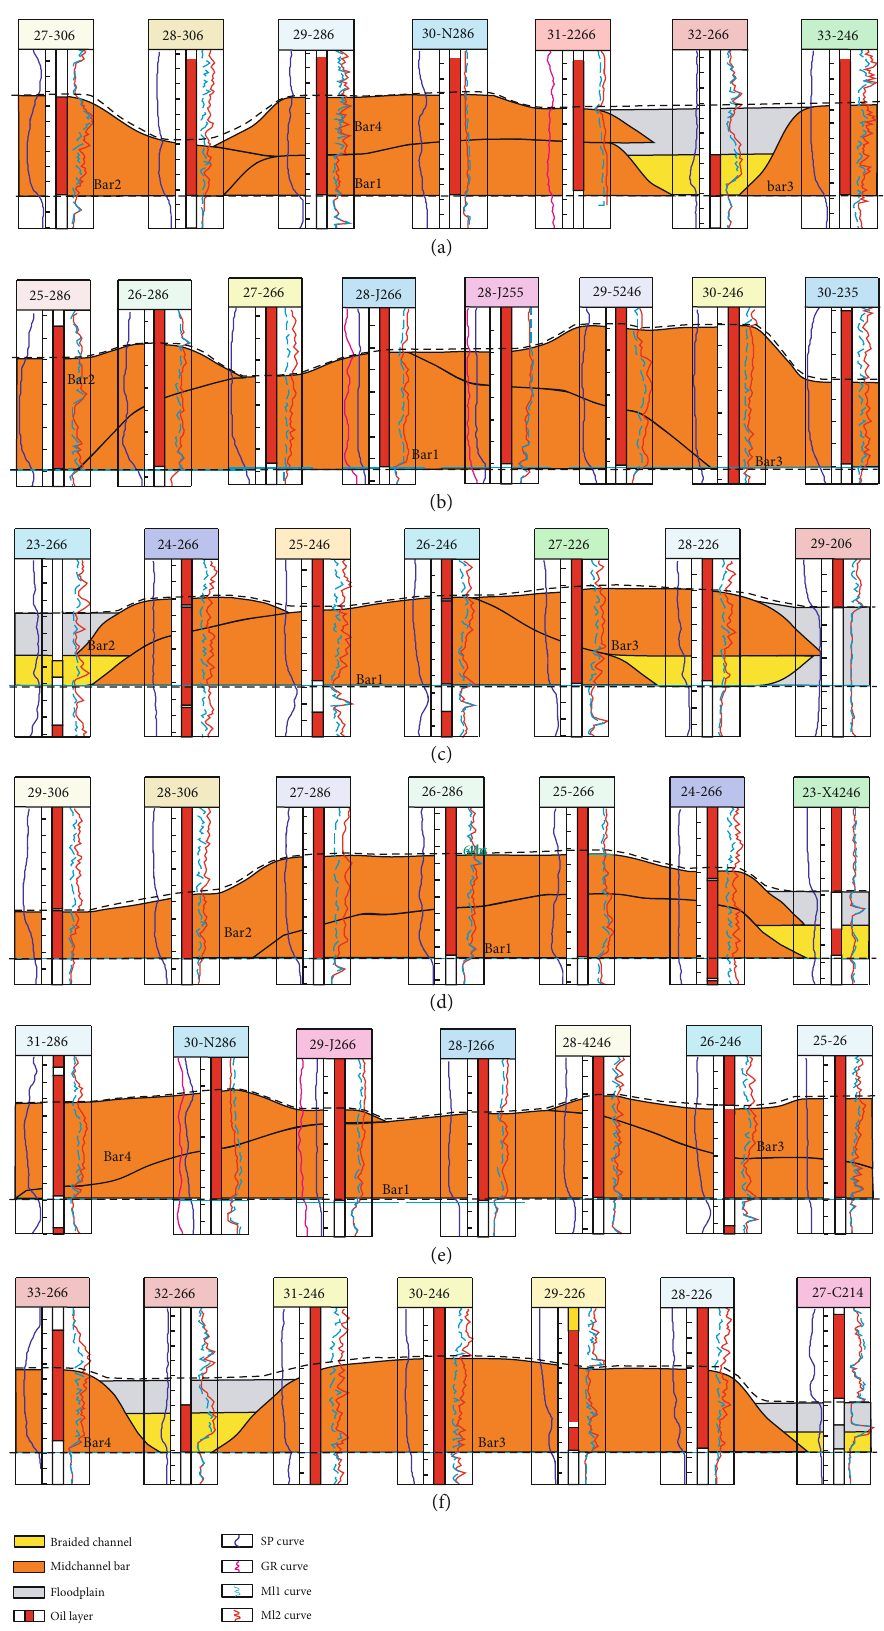
Figure 9: Identi fi cation pro fi les of single midchannel